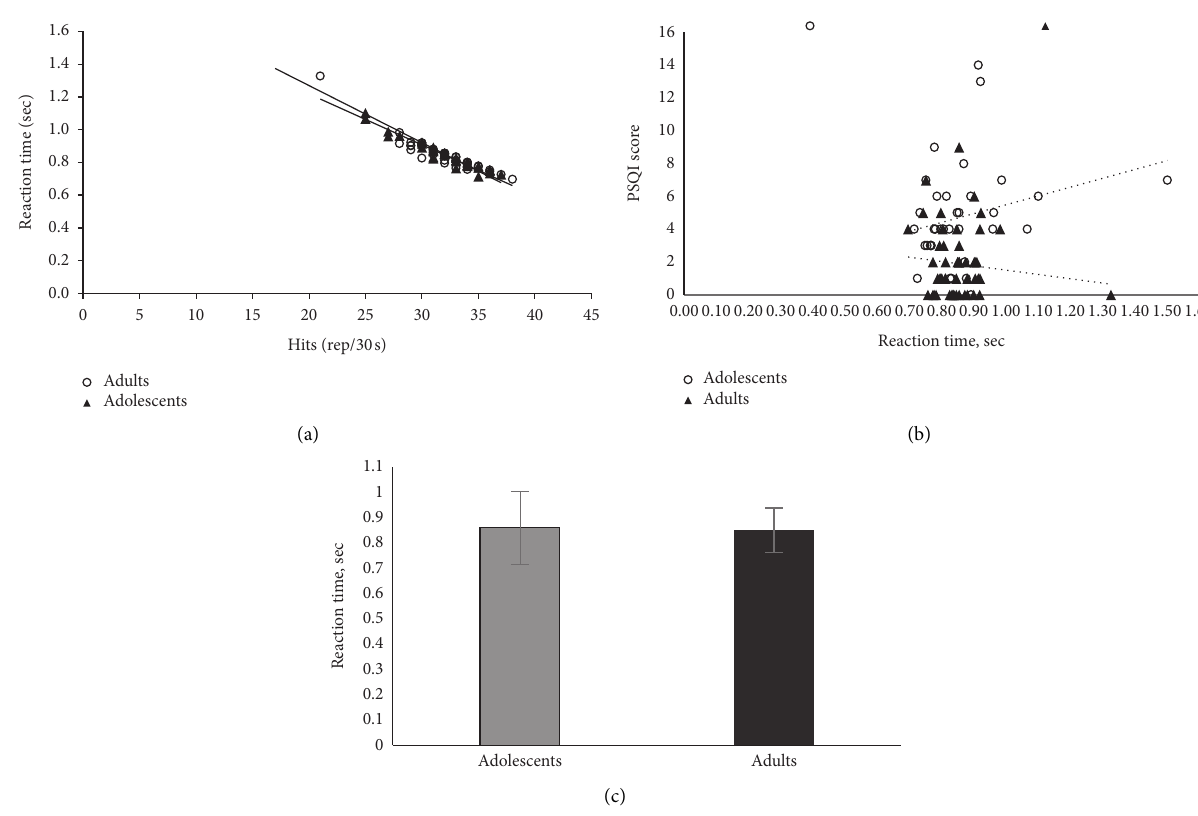
Figure 3: Relationship between reaction time and (a) hits (adults: y �− 0.031 x +1.8381, R 2 � 0.8726, P < 0 . 001; adolescents: y � − 0.0348 x +1.9653, R 2 � 0.9362, P < 0 . 001), (b) PSQI score (adults: y �− 2.6294 x +4.1389, R 2 � 0.0126, P � 0 . 265; adolescents: y � 5.3768 x +0.1151, R 2 � 0.1663, P � 0 . 046), and (c) age